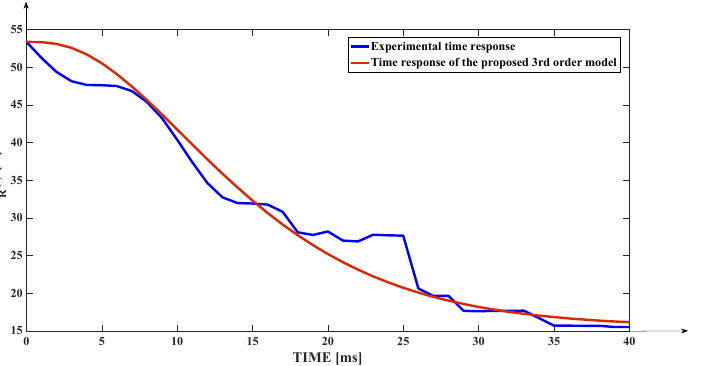
Figure 13. Comparative graph between the experimental response and the response of the third- order model.